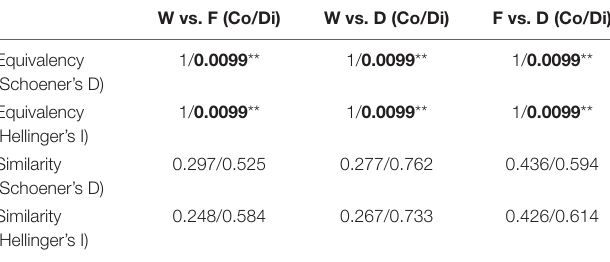
TABLE 3 | Similarity and equivalence tests p -values for niche conservatism (Co) and divergence (Di) hypotheses between wild (W), feral (F), and domesticated (D)